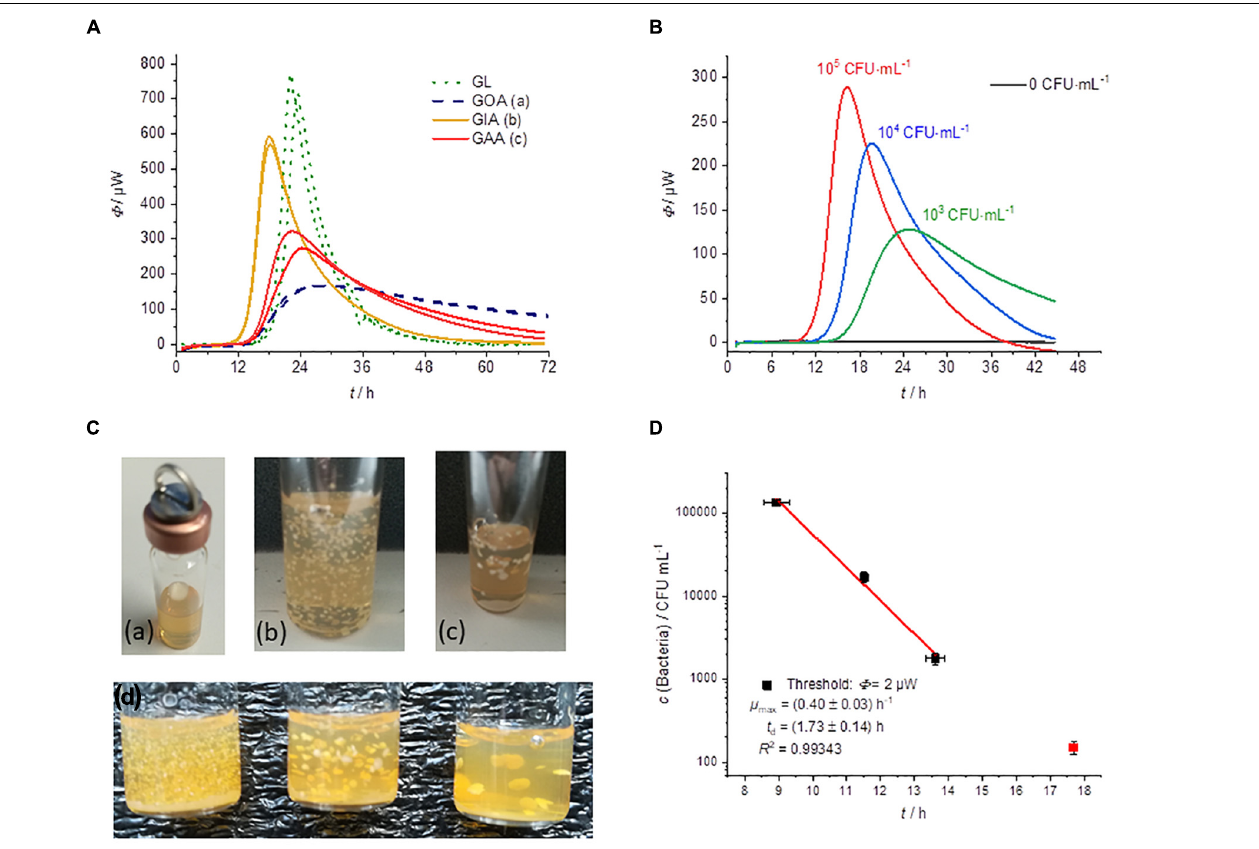
FIGURE 5 | (A) Heat flow measurements of GL (green dotted), GOA (blue dashed), GIA (orange), and GAA (red). All experiments were performed in 2000 µ L medium using an initial bacterial concentration of 10 3 CFU · mL − 1 . (B) Dependency of the heat traces on the initial bacterial concentration for GIA experiments. (C) Photographs of different cultivation techniques with solid media: (a) GOA, (b) GIA, (c) GAA, (d) GIA of inocula with densities that decrease from left to right. (D) Dependency of the detection on the initial bacterial concentration for GIA.